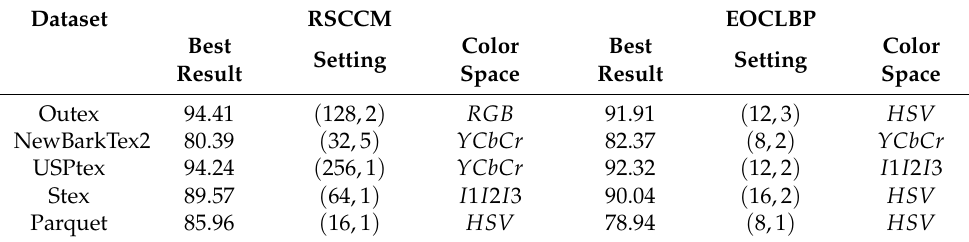
Table 5. Accuracy (in % of well-classified test images) obtained by the best configuration of each descriptor.